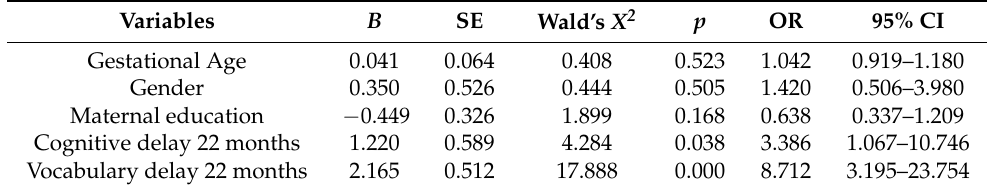
Table 7. Logistic regression analysis: predictors of LD in word production at 30 months of